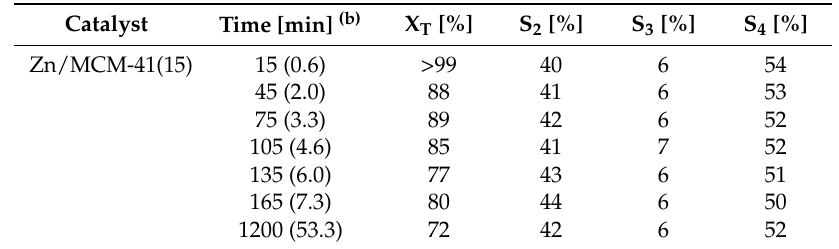
Table 4. Activities and selectivity of Zn/MCM-41 in the alkylation of toluene with benzyl chloride in flow chemistry (a) . Catalyst Time [min]